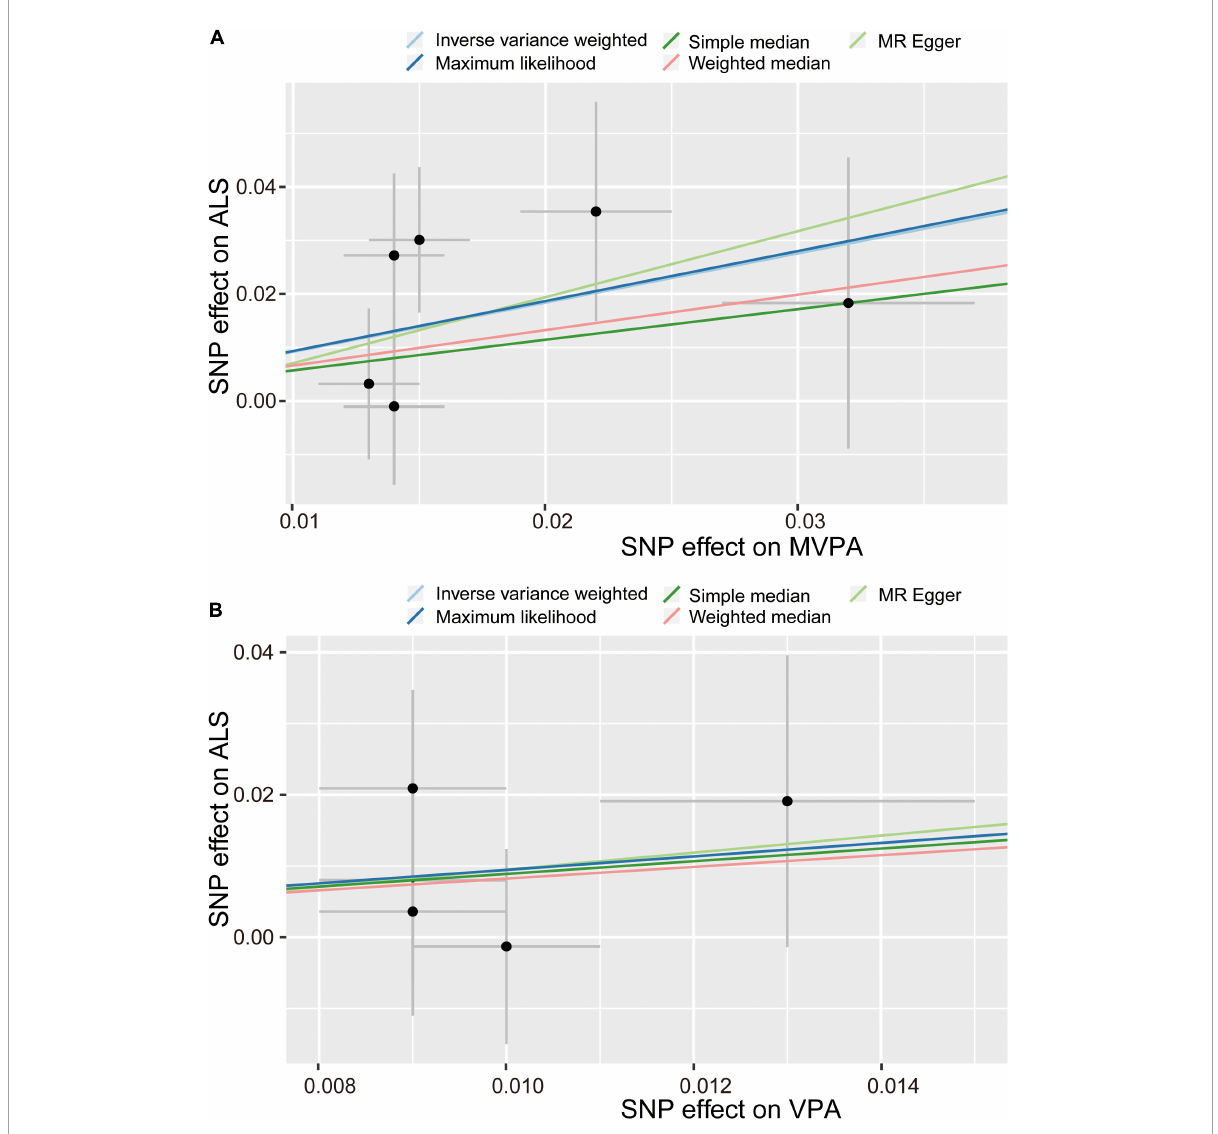
FIGURE2 Scatter plot of causal effect of MVPA (A) and VPA (B) on ALS. MVPA, Self-reported moderate-to-vigorous physical activity; VPA, Self-reported vigorous physical activity; SNP, single nucleotide polymorphism; ALS, amyotrophic lateral